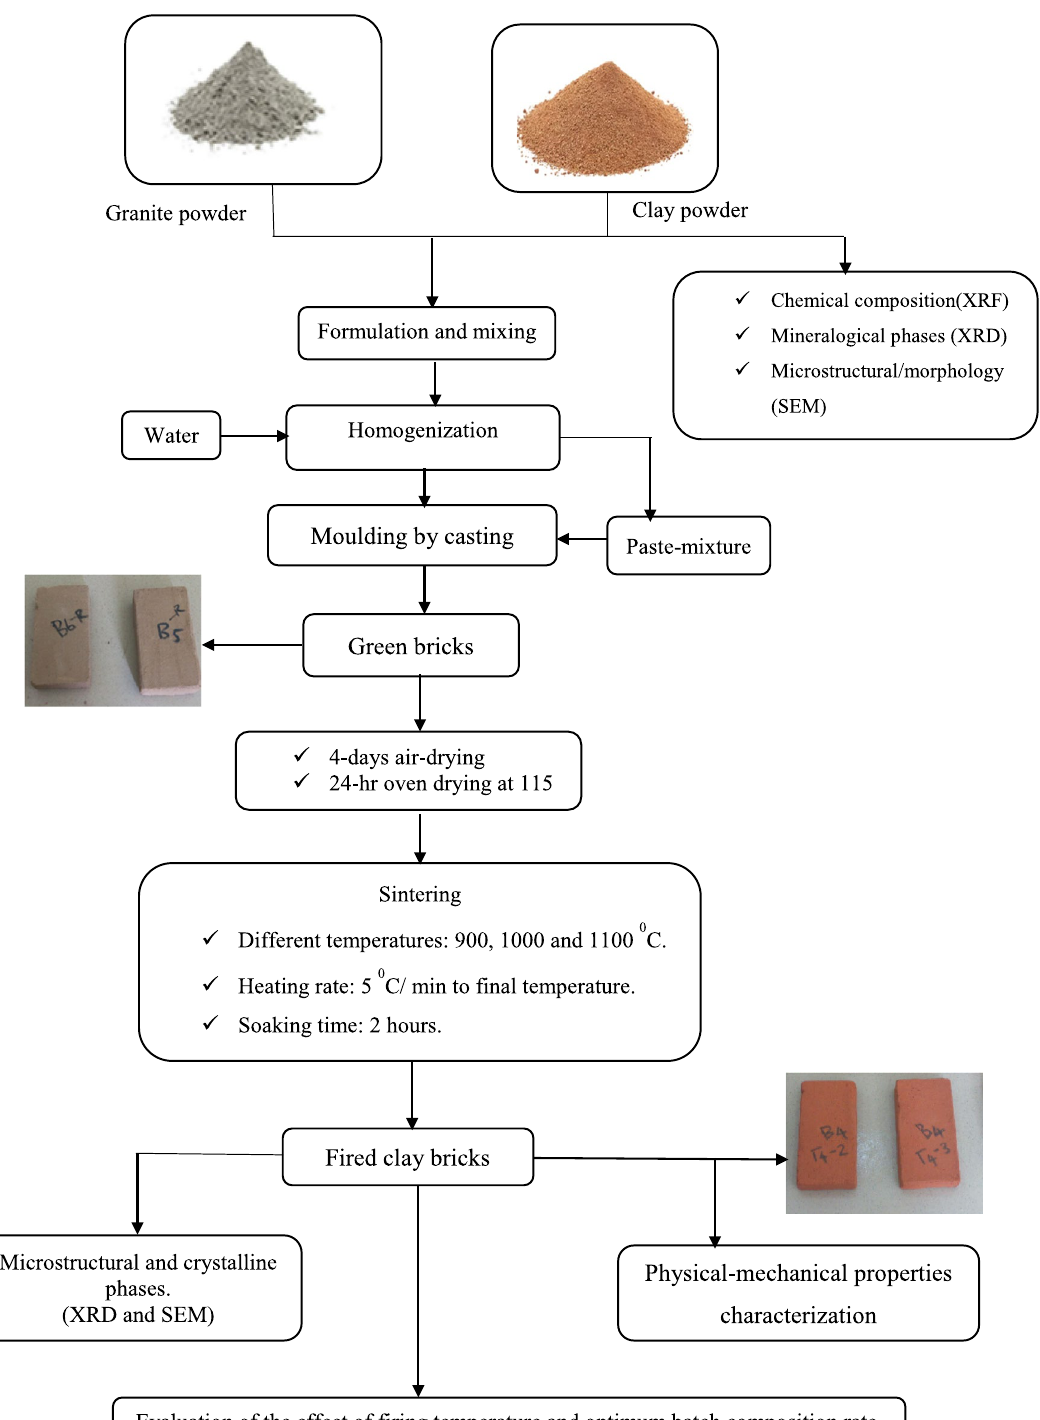
Fig. 1 Fired clay bricks production and Characterization